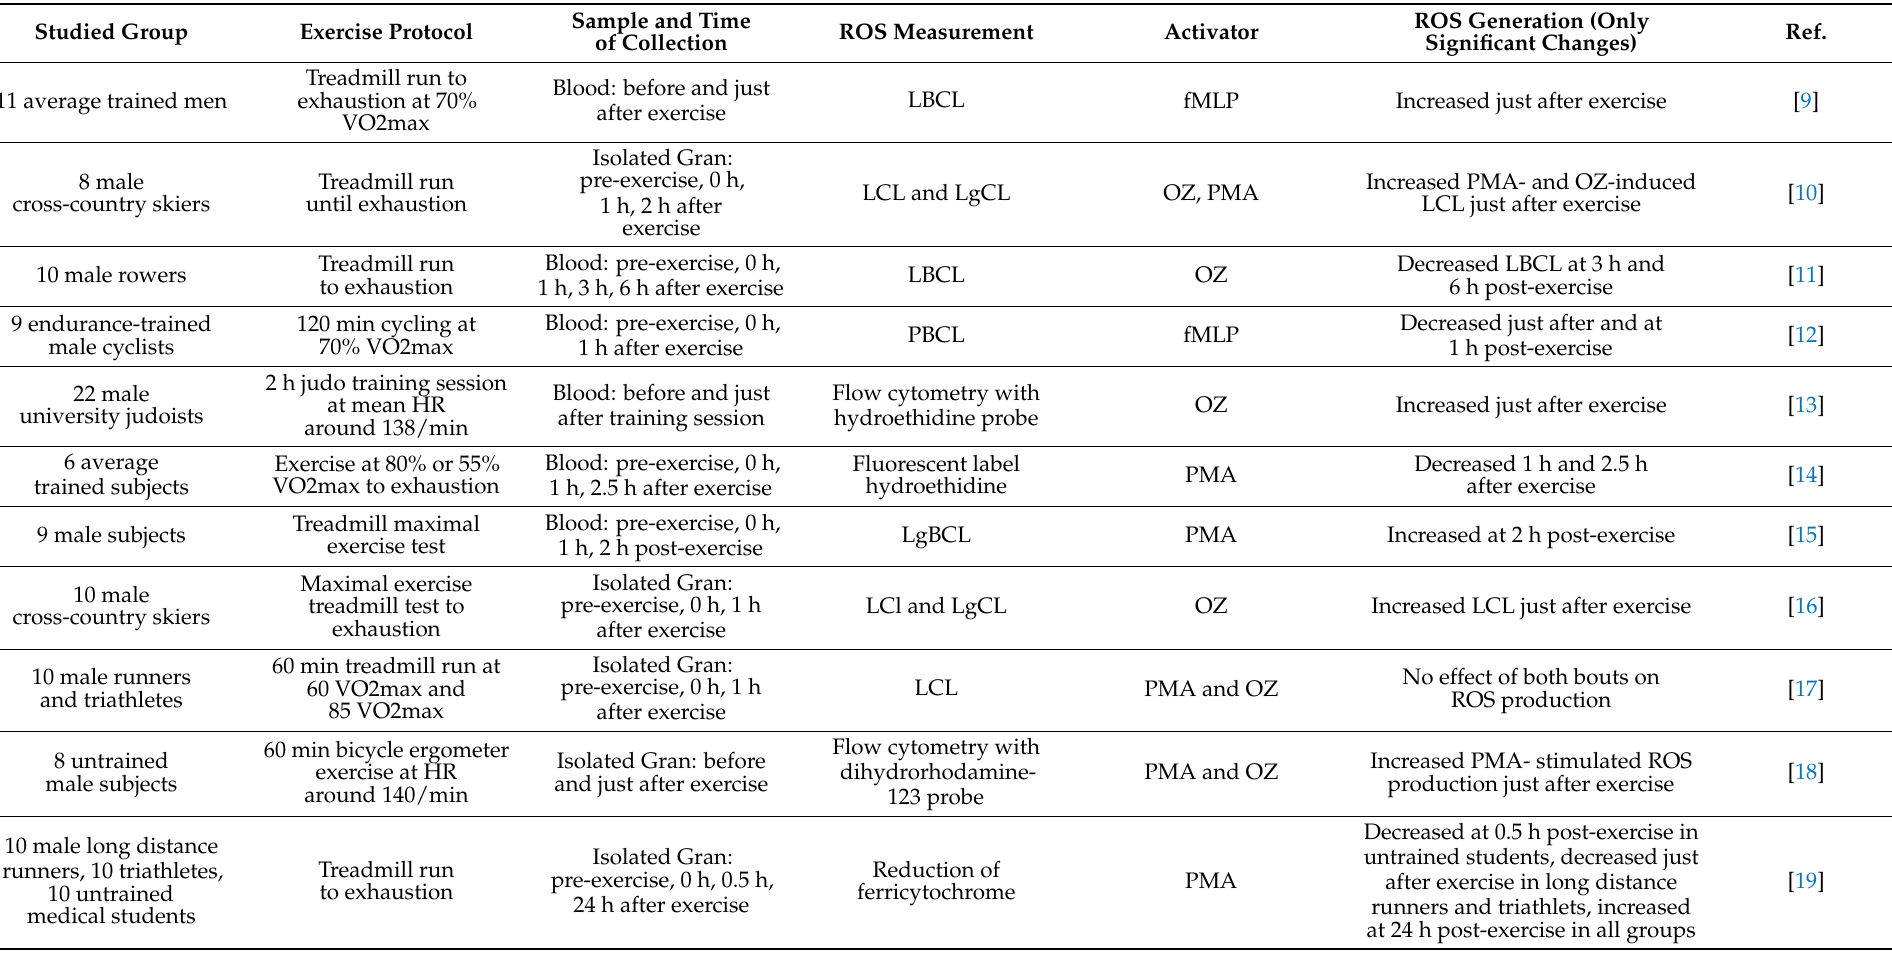
Table 1. Examples of discrepancies between results from clinical studies on the effect of a single bout of exercise on reactive oxygen species production by circulating granulocytes or phagocytes (granulocytes plus